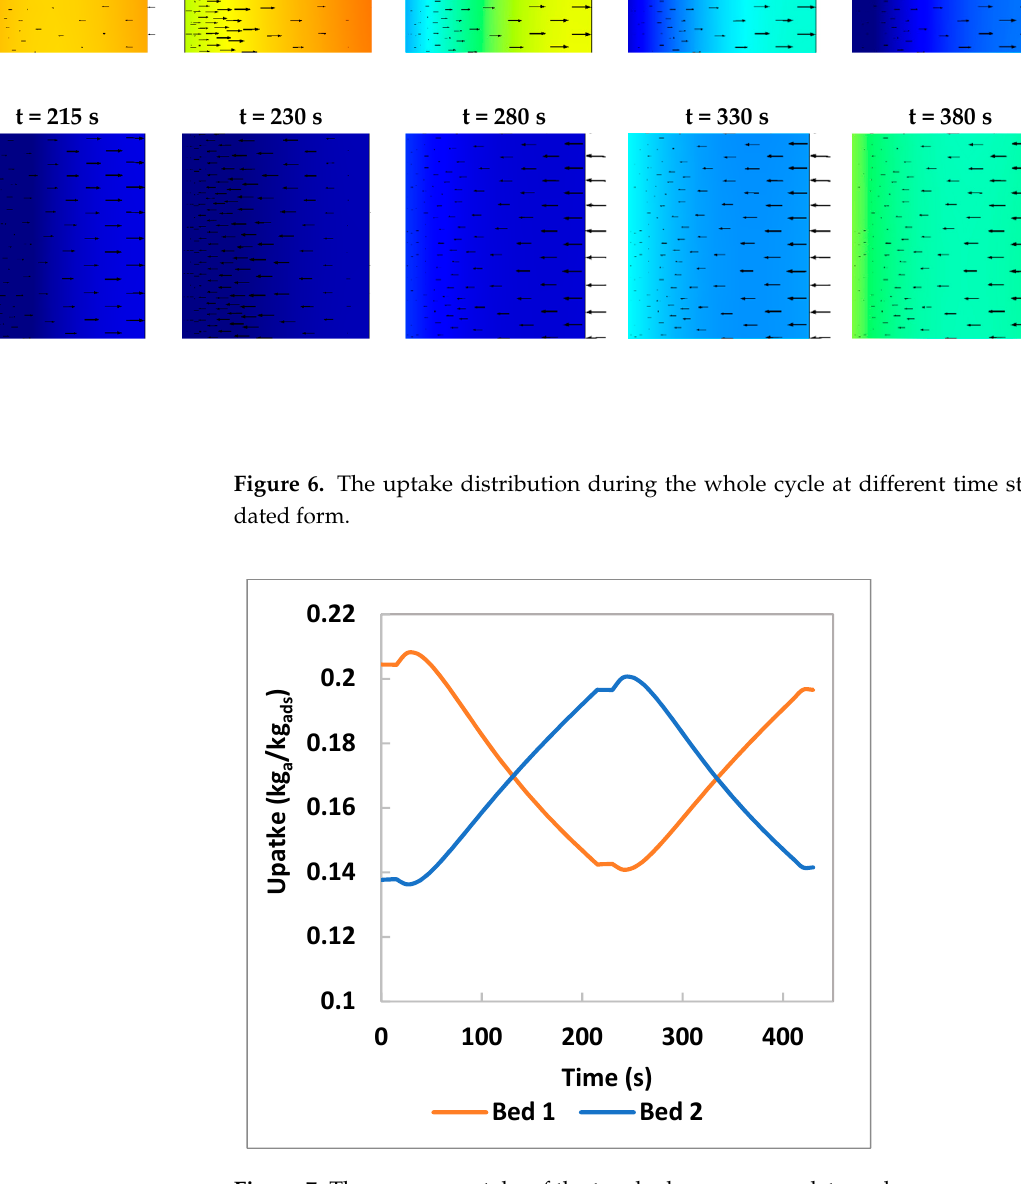
Figure 7. the average uptake of the two beds over a complete cycle . Figure 7. The average uptake of the two beds over a complete